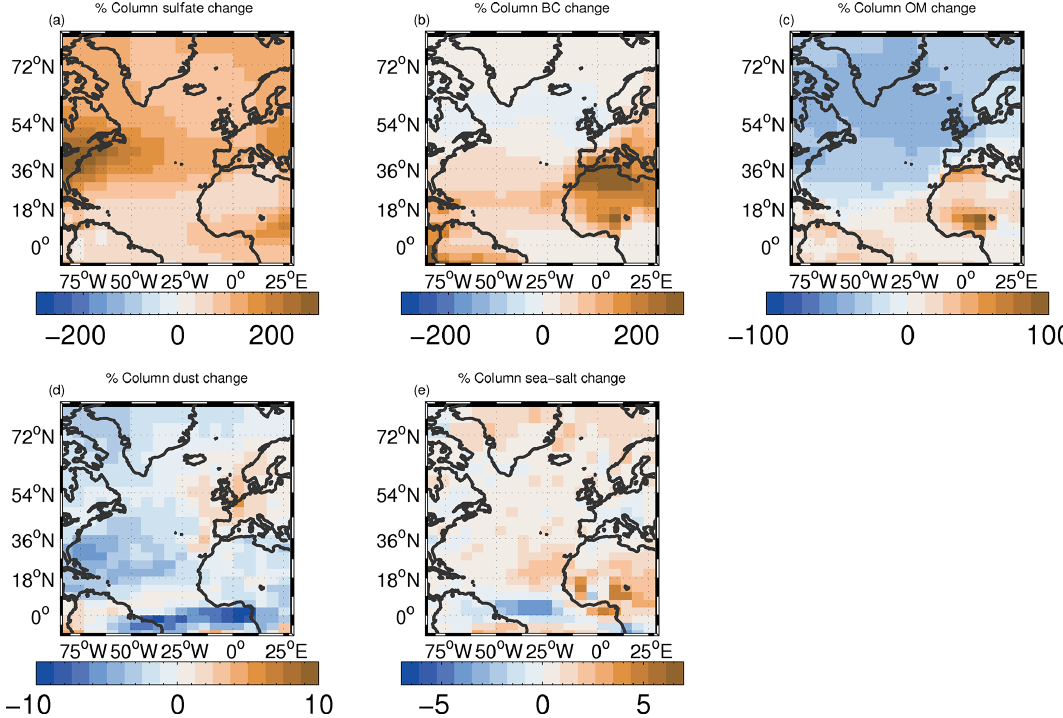
Figure C3. As for Fig. C2 except for changes in (a) column sulfate aerosol mass, (b) column BC aerosol mass, (c) column OM aerosol mass, (d) column dust mass and (e) column sea-salt aerosol